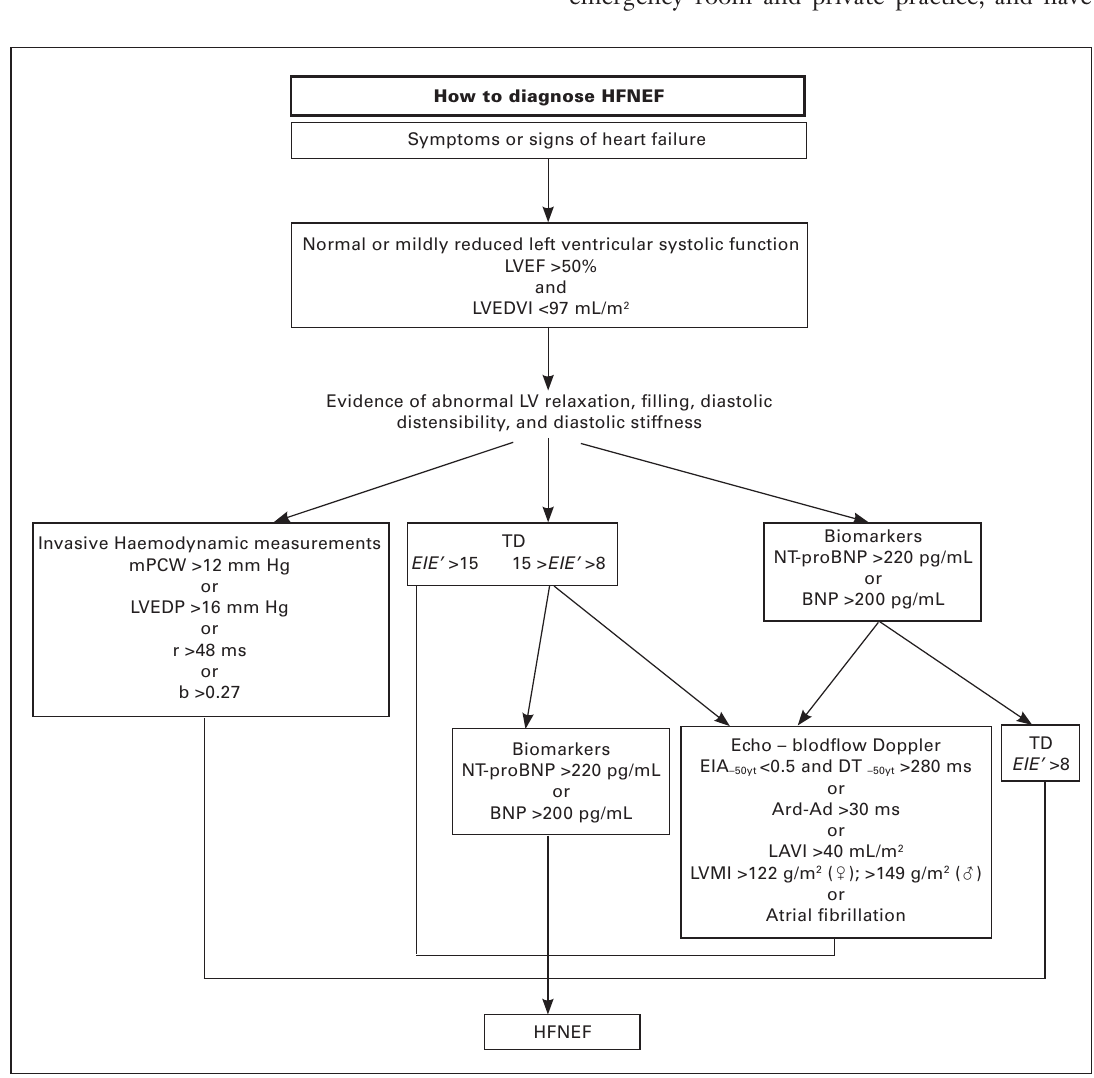
How to diagnose